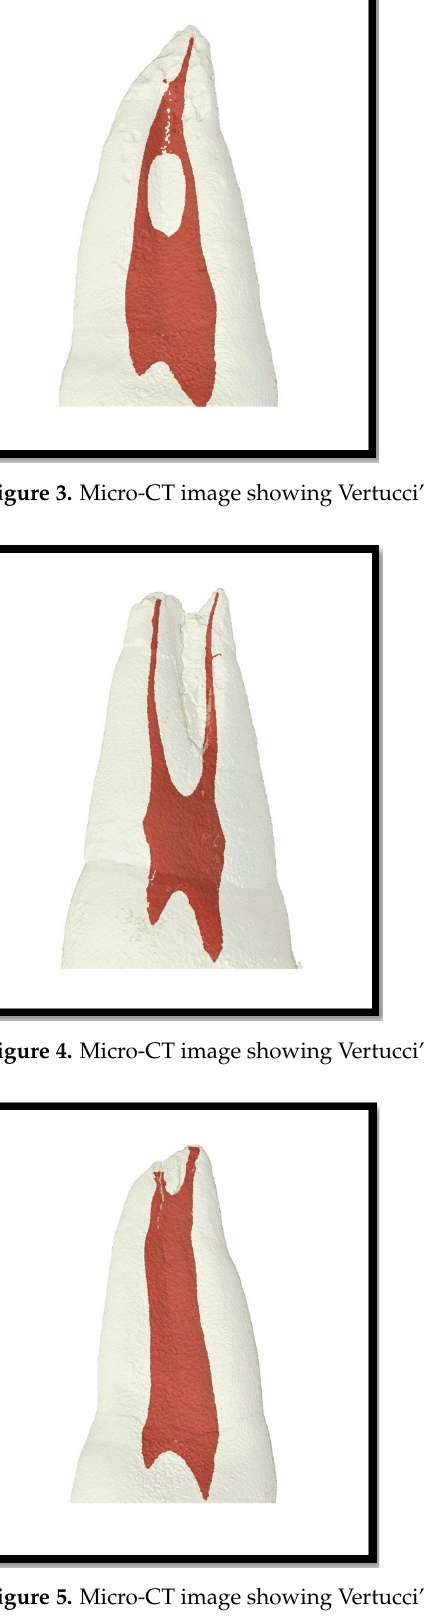
Figure 6. Micro-CT image showing Vertucci’s type VI (2-1-2) canal configuration. Figure 7. Micro-CT image showing Vertucci’s type VII (1-2-1-2) canal configuration.